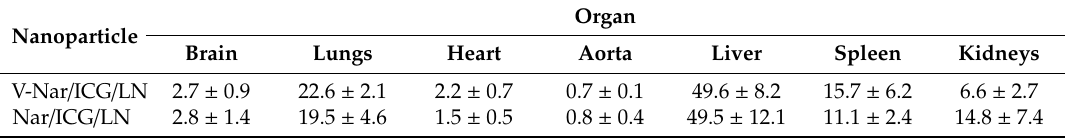
Figure 3. ( A ) UHPLC measurements of naringenin concentrations in the organs harvested from mice with LPS-induced inflammation at one hour after receiving intravenously ICG-labelled naringenin-loaded nanoemulsions, either non-targeted (Nar / ICG / LN) or VCAM-1 targeted (V-Nar / ICG / LN). Data represent the mean ± SD of values measured in organs isolated from 3 mice / experimental group; * p < 0.05. ( B – E ) Correlation between UHPLC measurements of naringenin content and fluorescent measurements of ICG radiant e ffi ciency in organs from mice with LPS-induced inflammation. ( B – D )Linearregressionplotsofnaringenincontentandradiante ffi cienciesinorgansfrom mice in groups receiving ( B ) Nar / ICG / LN and V-Nar / ICG / LN , ( C ) Nar / ICG / LN, and ( D ) V-Nar / ICG / LN. ( E ) Results of correlation analysis by Pearson and Spearman methods. Table 2. Percentages of naringenin detected by UHPLC in the organs harvested from mice with LPS-induced inflammation at one hour after receiving intravenously ICG-labelled naringenin-loaded nanoemulsions, either non-targeted (Nar / ICG / LN) or VCAM-1 targeted (V-Nar / ICG / LN). Percentages were calculated relative to the total amount of naringenin in all organs for each experimental group. Data represent the mean ± SD of values for 3 mice / experimental group. Nanoparticle